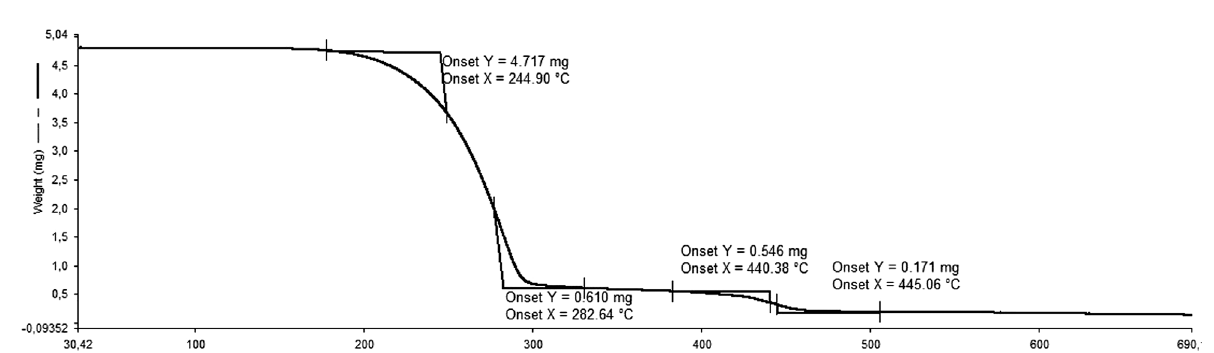
Figure 11: TGA thermogram of poly(NBMP).